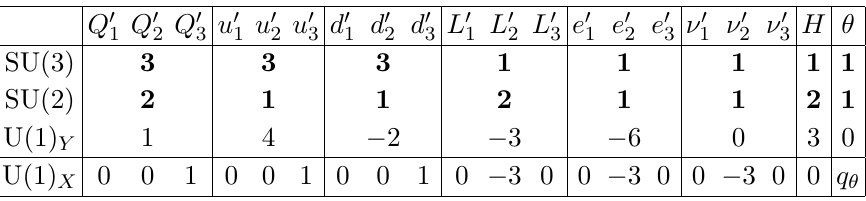
Table 2 . Representations of fields under the SM gauge factors, which are family universal, together with their representations under the family non-universal gauged U(1) X symmetry on which our Z 0 model is based. We use the minimal integer normalisation for the charges under each U(1) factor and we shall specify q θ ∈ {− 1 , 1 } . All fields are Weyl fermions except for the complex scalar Higgs doublet H and the complex scalar flavon θ